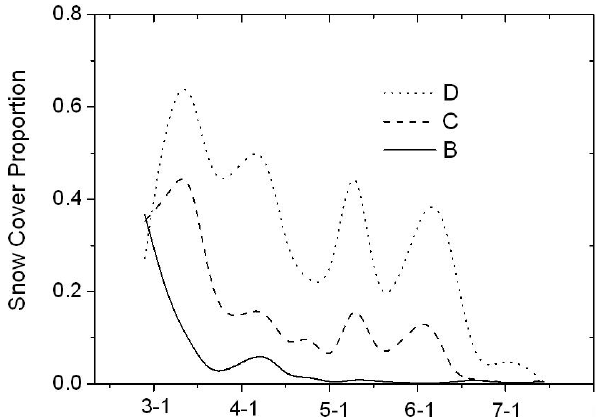
Fig. 4. Annual air temperatures of weather stations over the past 50